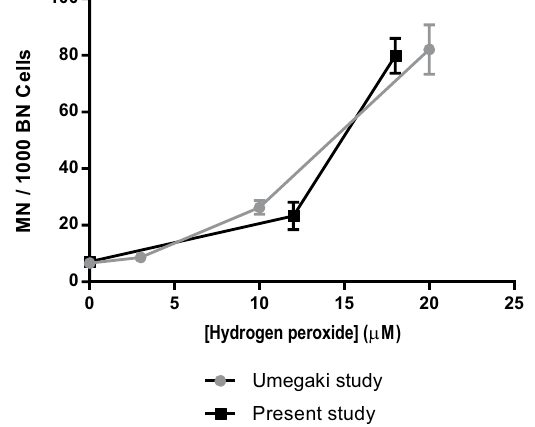
Figure 6. MN frequency in WIL2-NS cells as function of H 2 O 2 concentration. The trend in MN formation versus